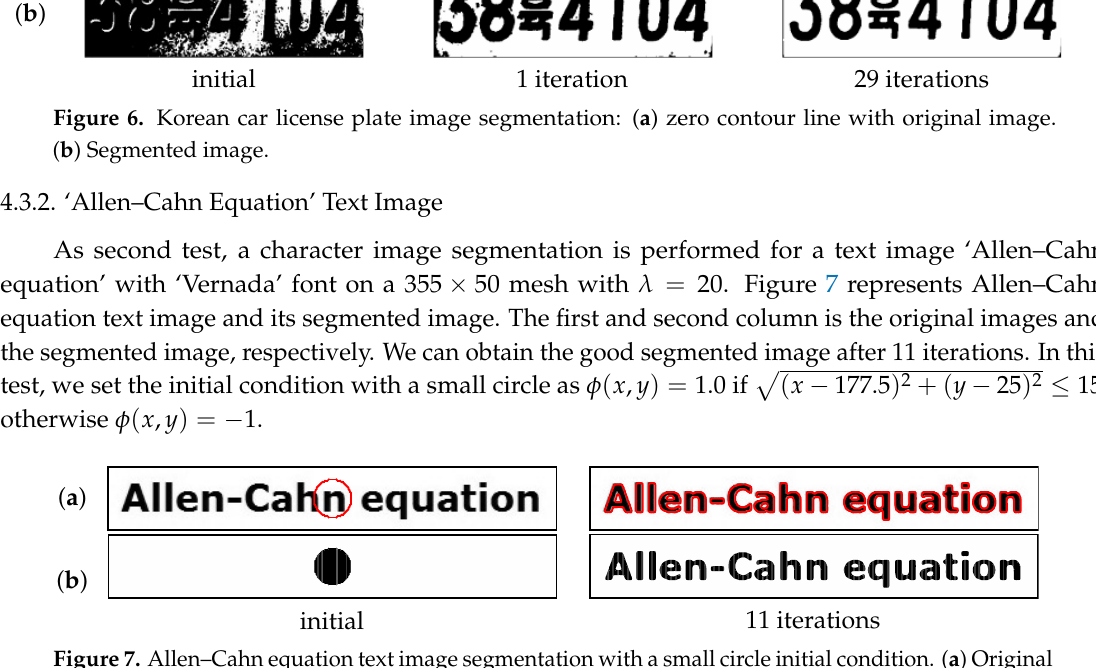
Figure 7. Allen–Cahn equation text image segmentation with a small circle initial condition. ( a ) Original image and contour line. ( b ) Filled